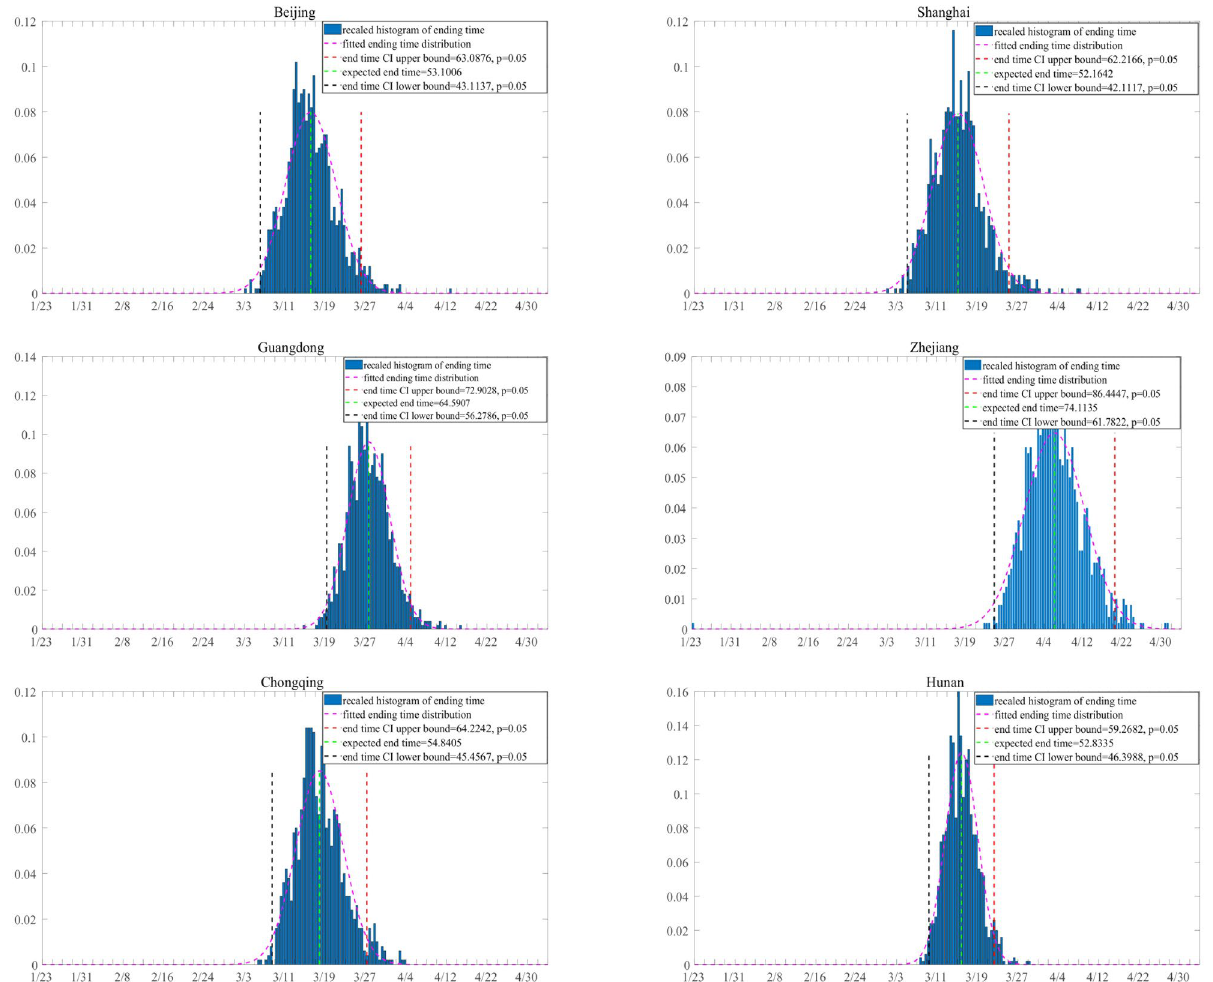
Figure 5. Prediction of the containment time of the outbreak with q = 0. The containment time of 1000 simulations is plotted as a histogram and is fitted with normal distribution for each region. The y axis represents the density of containment